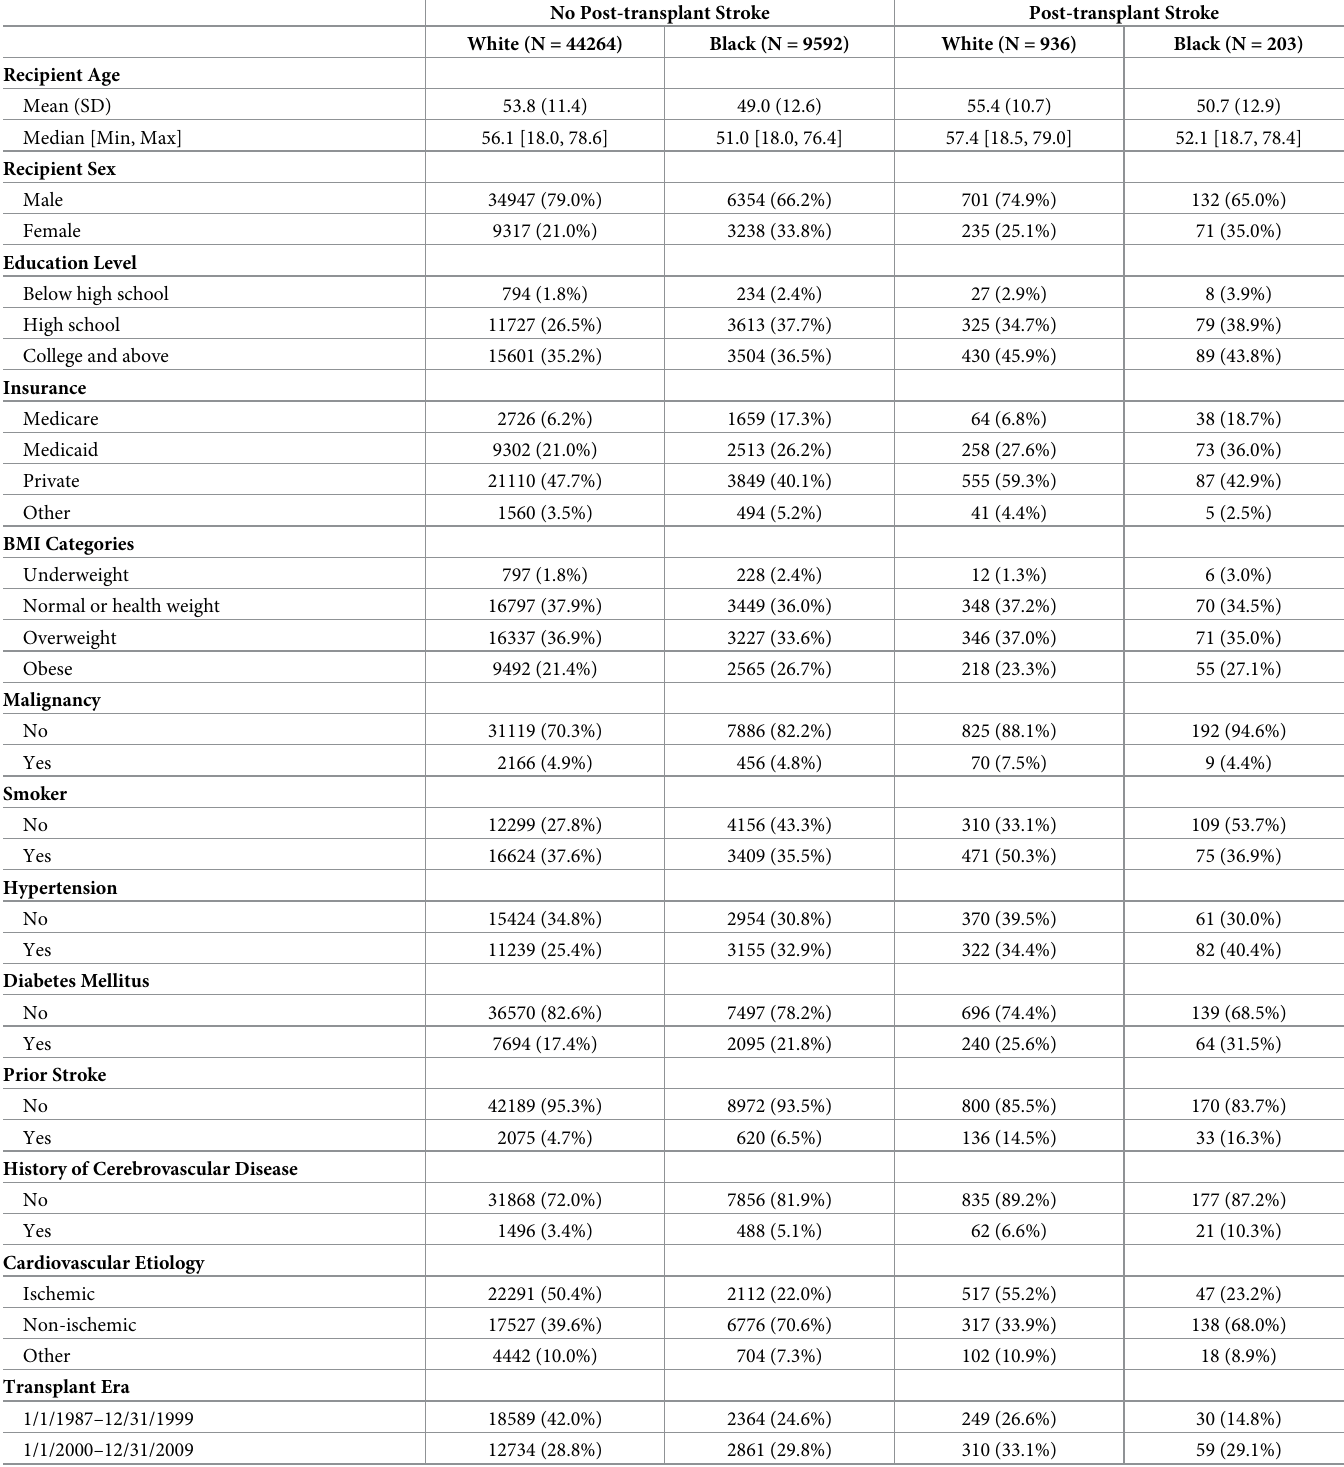
Table 1. Heart transplant recipient characteristics by race and post-transplant stroke, Scientific Registry of Transplant Recipients (SRTR), January 1, 1987 to December 31, 2018; n (%) unless otherwise